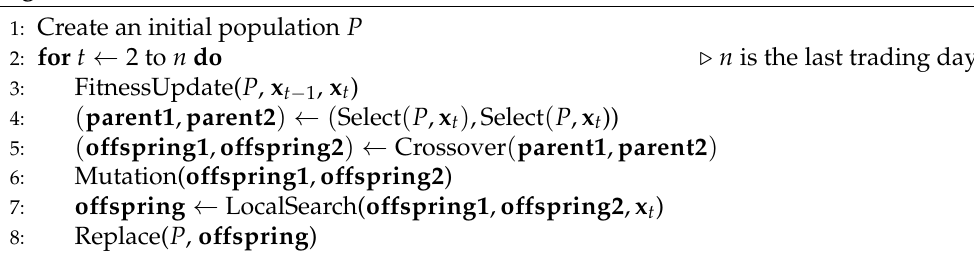
Algorithm 1 The outline of our HGA.